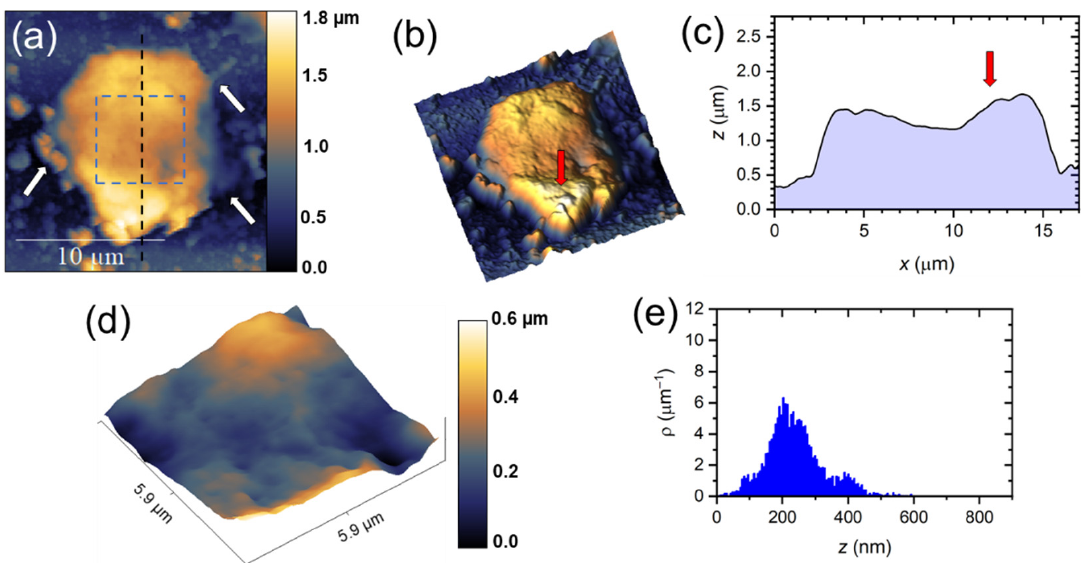
Figure 5. Representative AFM image of an acute lymphoblastic leukemia cell cultured on the TiO 2 -m coating for 60 min. ( a ) Two-dimensional and ( b ) three-dimensional topography images. ( c ) Height profile taken along the dashed line in ( a ). The white arrows in ( a ) indicate pseudopodia formation. While the cell membrane in general appears rather smooth, some remaining protrusions can still be identified close to the membrane boundary (red arrows in ( b , c )). ( d ) Three-dimensional representation of the zoomed area indicated in ( a ). ( e ) Height distribution function calculated for the zoomed image shown in ( d ). The height z = 0 nm corresponds to the lowest height value within the zoomed region in ( d ).